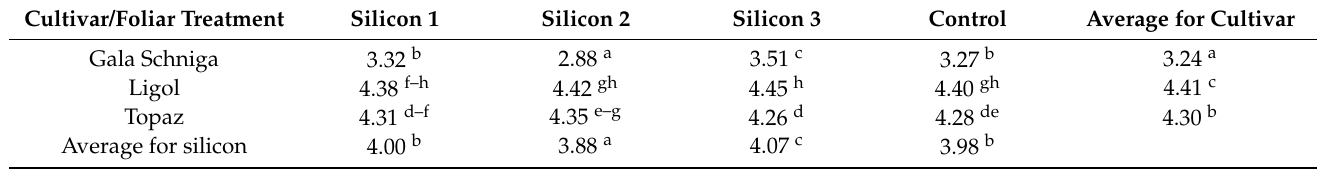
Table 12. The acidity of fruits depends on cultivar and foliar silicon treatment (g · L − 1 of malic